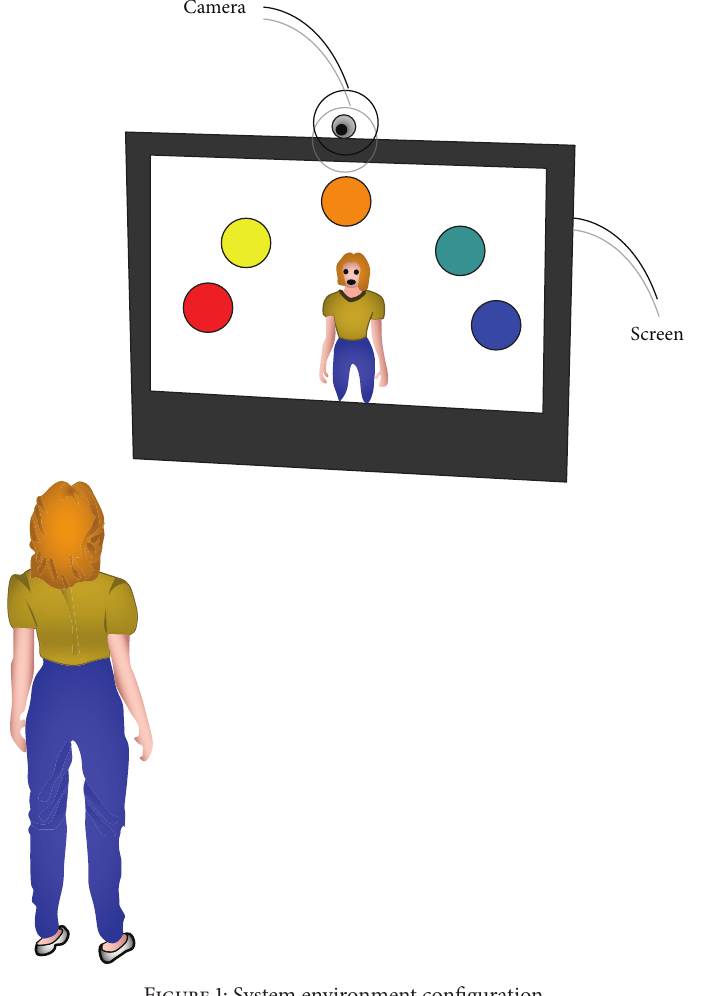
Figure 1: System environment configuration.